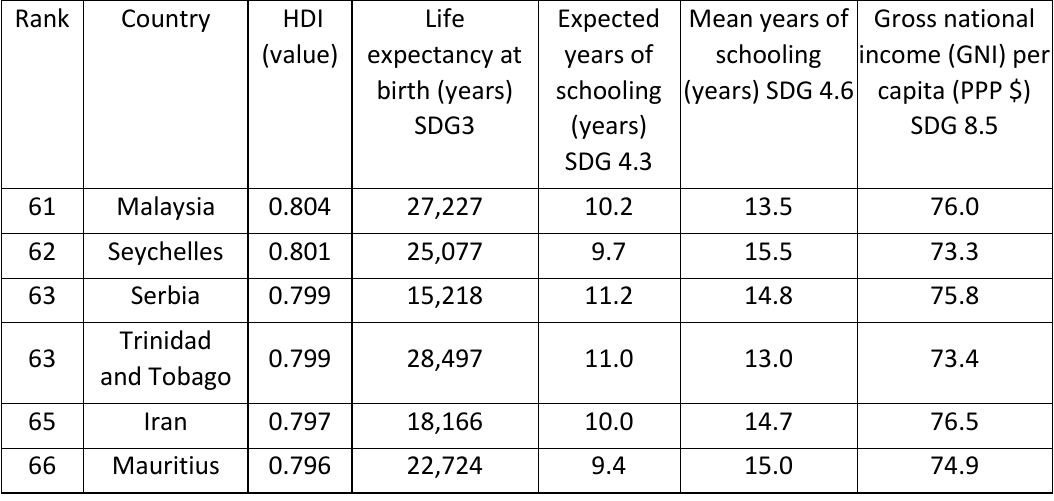
Table 2: Classification of countries based on